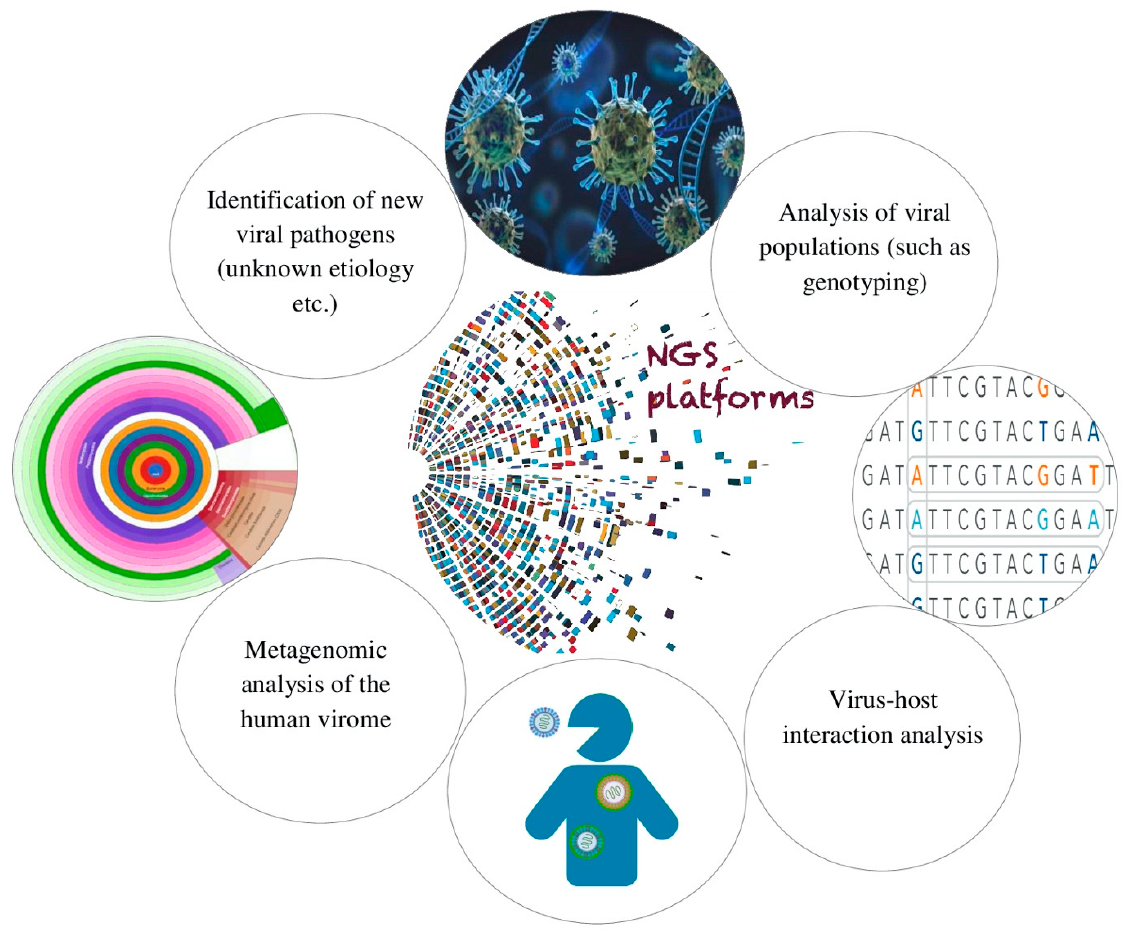
Figure 2. Purposes of use of NGS platforms in clinical virology laboratories.